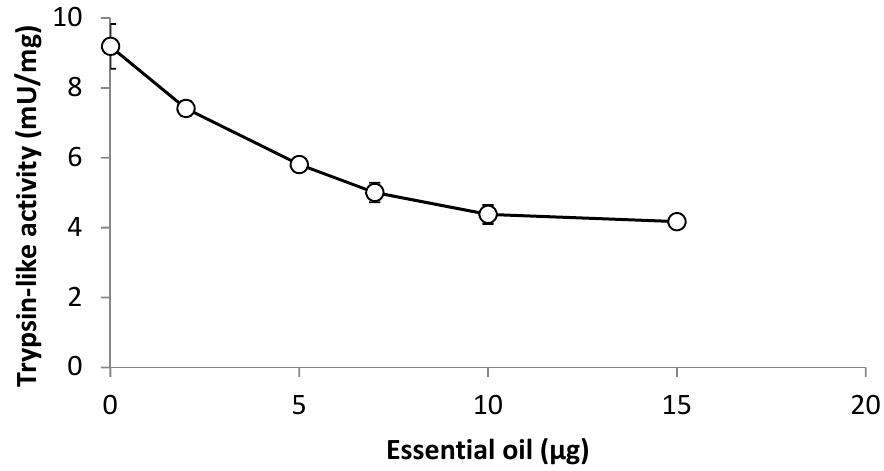
Figure 1. Effect of the leaf oil of Croton rhamnifolioides on the trypsin-like activity of Aedes aegypti 4th instar